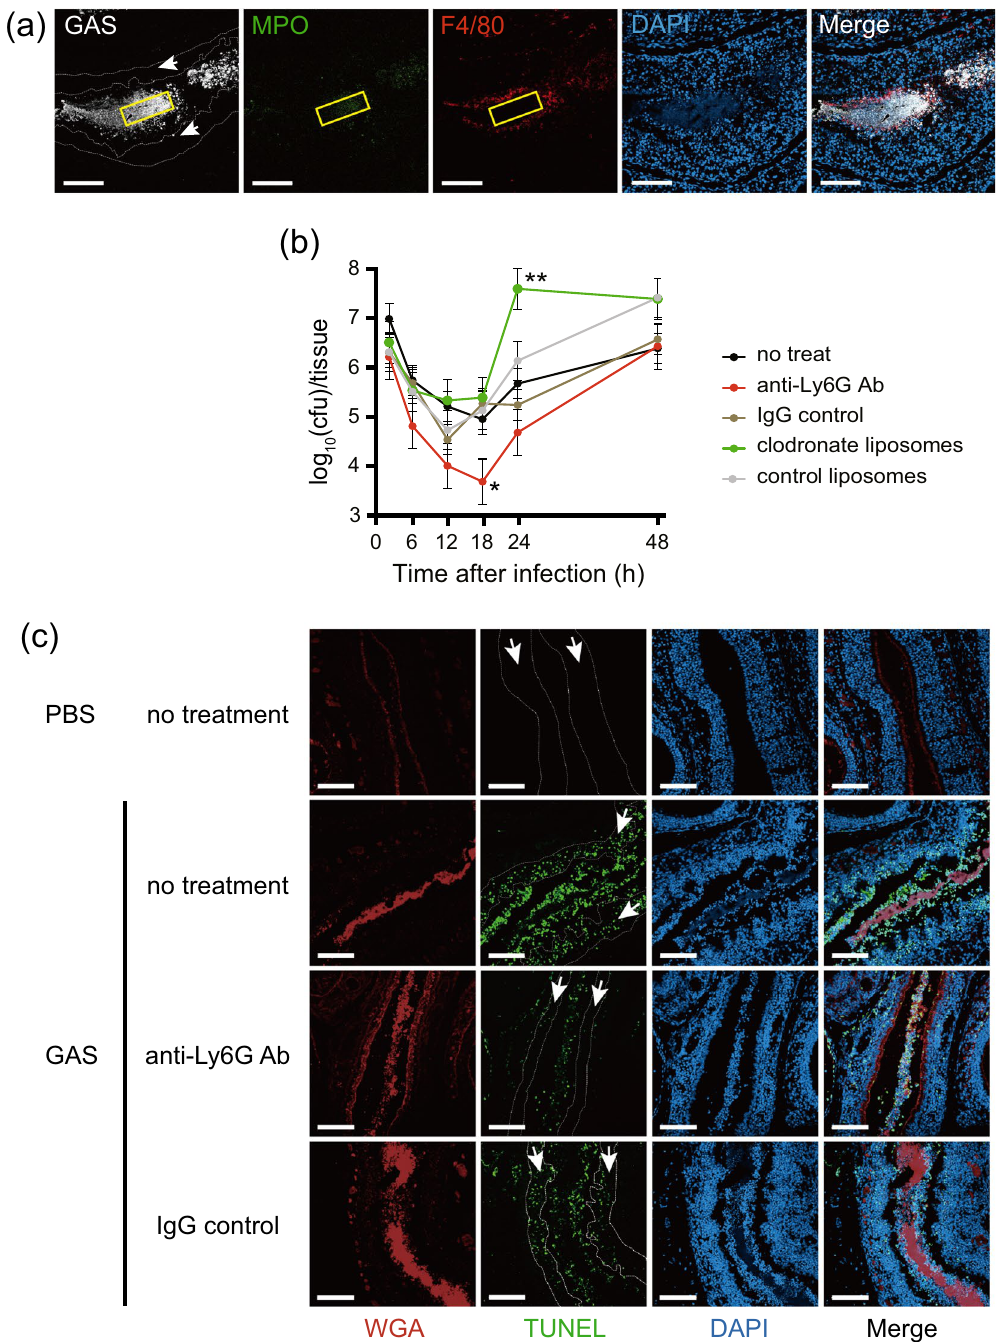
Figure 2. Depletion of neutrophils from mice decreased GAS colonization and damage to the nasal mucosa. ( a ) Neutrophils accumulated at the local infection site 24 h after nasal infection with the ATCC 11434 strain. Staining with an anti-GAS antibody (white), neutrophil staining with an anti-MPO antibody (green), macrophage staining with an anti-F4/80 antibody (red), and DAPI staining (blue) were performed. The region enclosed by the yellow line is the center of a bacterial aggregate, and the region enclosed by the white dotted line (arrow) represents the epithelial layer. Bars indicate 100 μ m. ( b ) Time-course analysis of the bacterial count in the maxillary sinus after nasal infection with the ATCC 11434 strain. The following 5 groups underwent intranasal infection with 5 × 10 8 CFU of the ATCC 11434 strain 24 h after the indicated treatments: Intact C57BL/6 mice (no treatment), mice treated with an anti-Ly-6G antibody (anti-Ly6G Ab), mice treated with clodronate liposomes (clodronate liposomes), mice treated with a control IgG antibody (IgG control), and mice treated with control liposomes (control liposomes). The number of live bacteria in the maxillary sinus was counted by seeding specimens on blood agar medium 2, 6, 12, 18, 24, and 48 h after infection. * p < 0.01 (the Student’s t -test, vs. IgG control) ** p < 0.01 (the Student’s t -test, vs. control liposomes). ( c ) Damage to the nasal mucosal epithelium by GAS in mice without neutrophils. Immunostained nasal mucosal epithelial layers 12